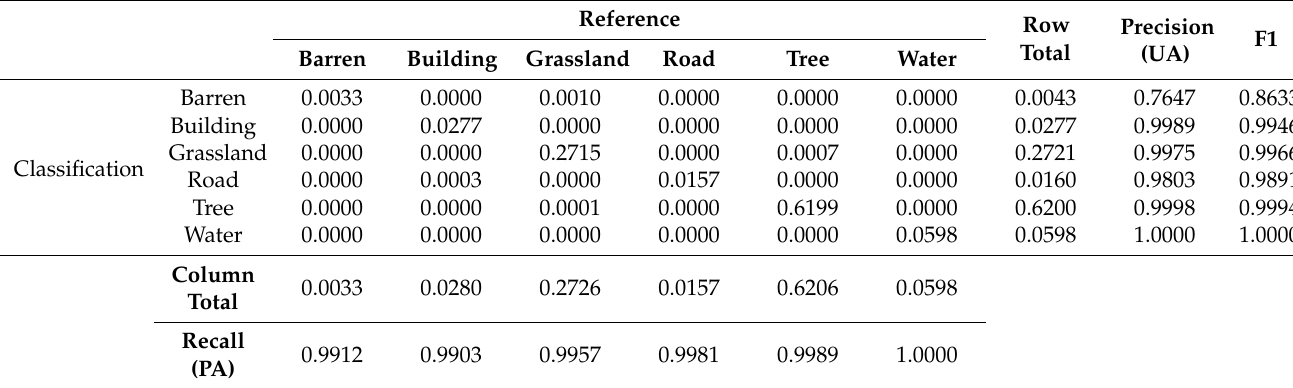
Table 6. Scene labelling accuracy assessment for DeepSat SAT-6 dataset, with class prevalence set to equal the estimated prevalence in the Chesapeake Bay region obtained from [74], and thus the confusion matrix represents an estimate of the population matrix. OA =